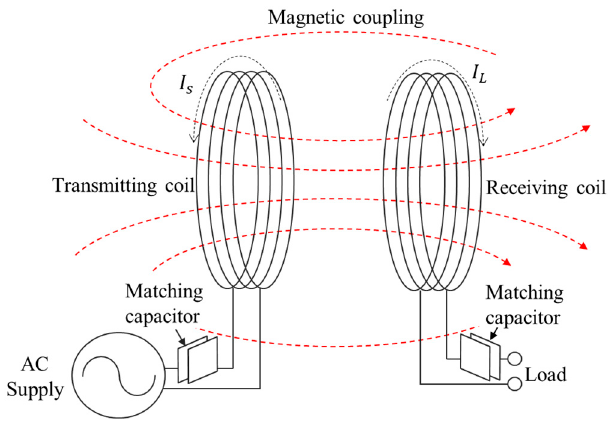
Figure 1. Conceptual diagram of the wireless power transfer system. Magnetic coupling enables electrical energy to be transferred wirelessly.